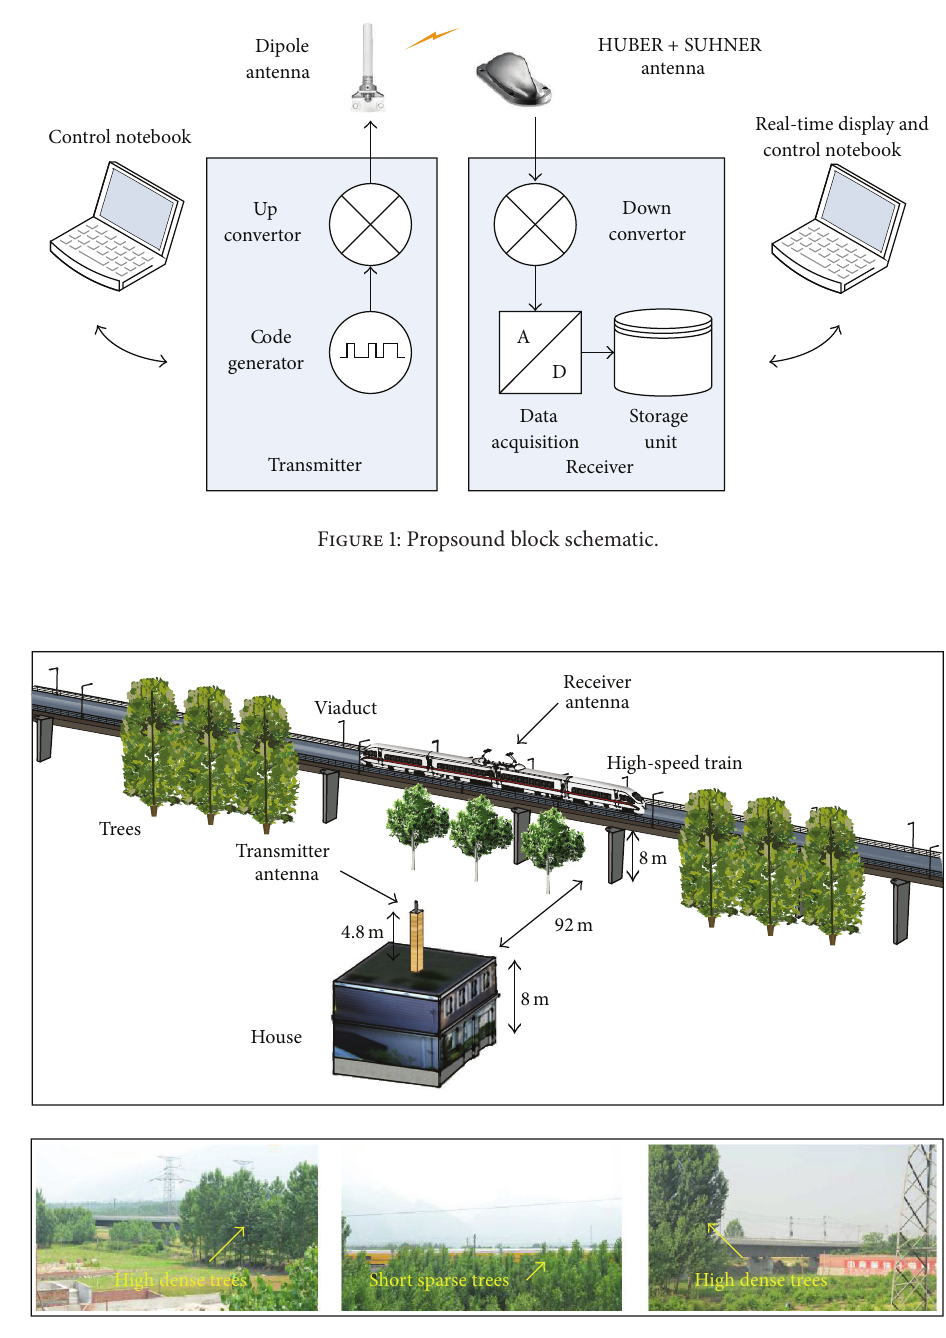
Figure 2: The measured viaduct scenario and corresponding